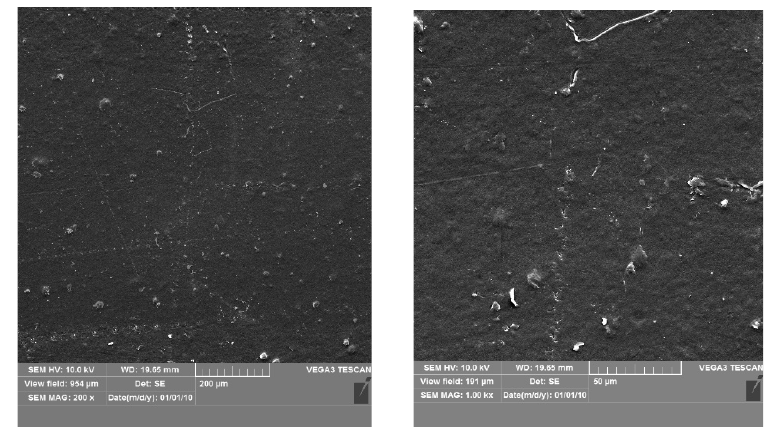
Figure 4. The PE film-covered M2 coating.